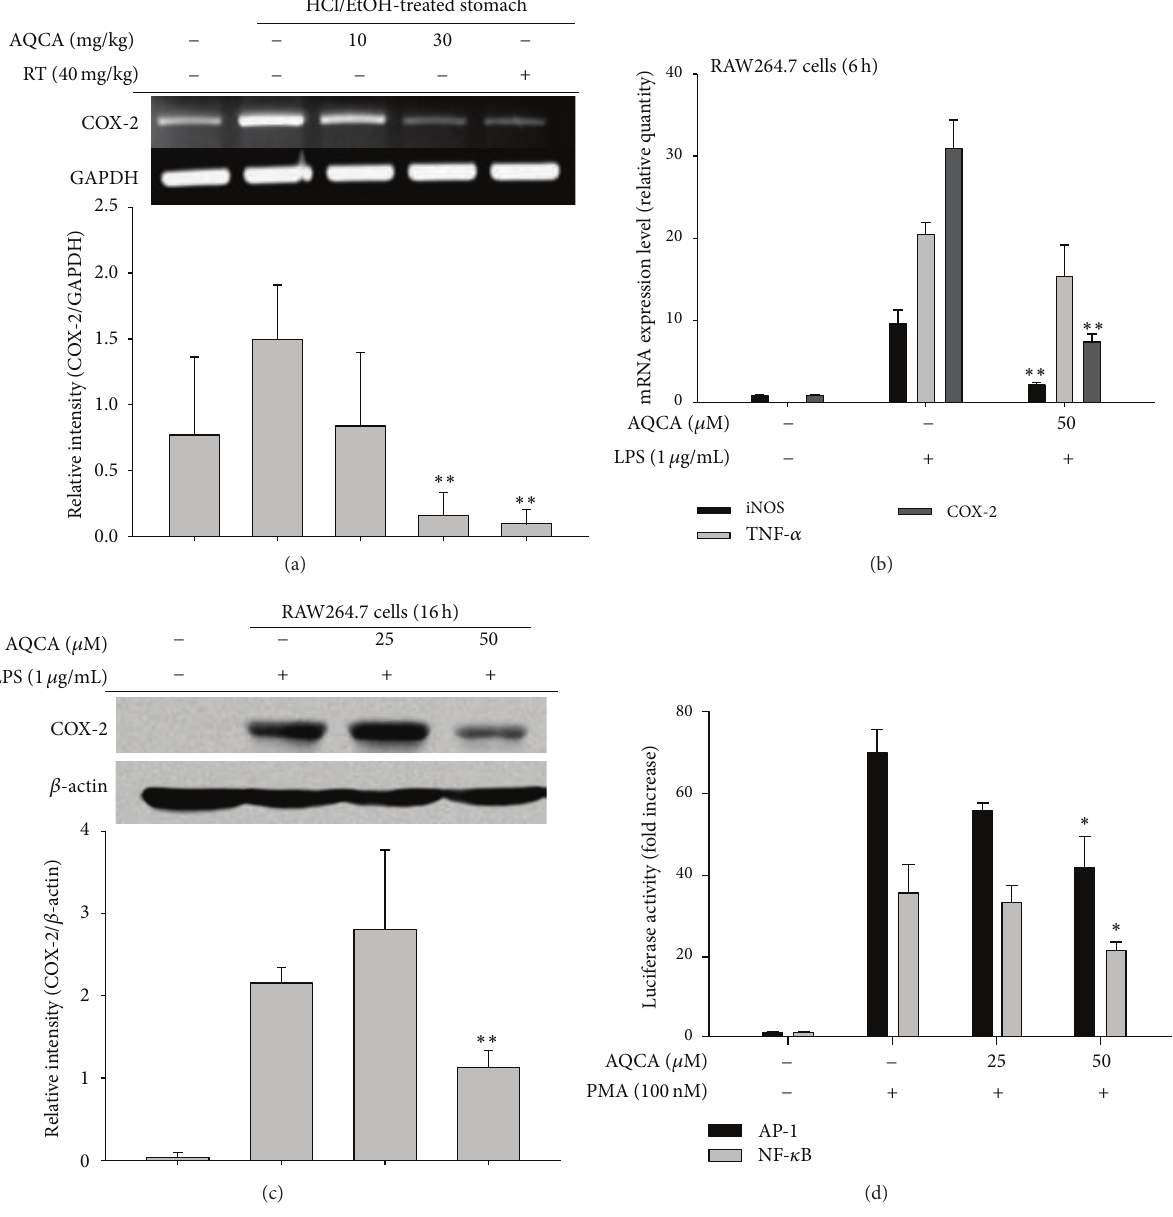
Figure 4: Effect of AQCA on the transcriptional activation of inflammatory genes. (a and b) mRNA levels of inflammatory genes (iNOS, TNF- 𝛼 , and COX-2) in mice treated with HCl/EtOH or LPS-treated RAW264.7 cells were determined by semiquantitative (a) and real-time RT-PCR (b). (c) Total lysates were prepared from LPS-treated RAW264.7 cells treated with AQCA (25 and 50 𝜇 M). The total forms of COX-2 and 𝛽 -actin were analyzed by immunoblotting analysis. (d) Promoter binding activities of NF- 𝜅 B and AP-1 in the presence or absence of PMA were determined by reporter gene (luciferase) assay. Relative intensity (a and c) was calculated using level of GAPDH or 𝛽 -actin and the DNR Bio-Imaging System (a and c bottom panels). ∗ 𝑃 < 0.05 and ∗∗ 𝑃 < 0.01 compared with the control